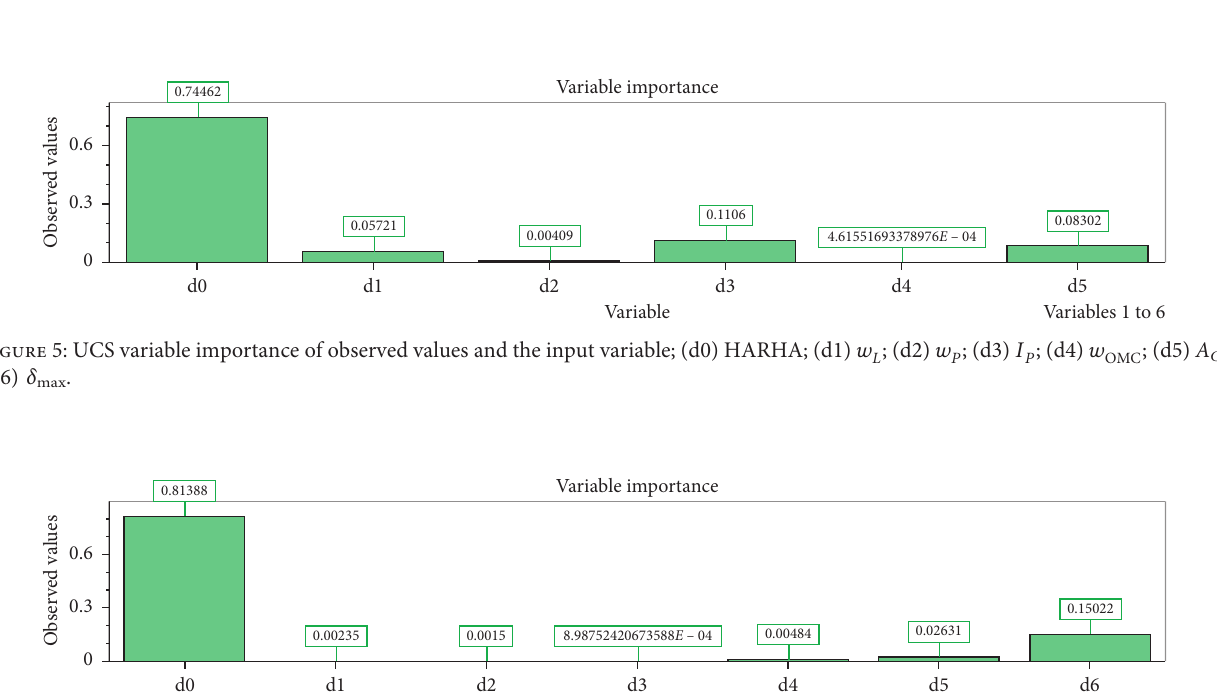
w I w ; (d5) L ; (d2) P ; (d3) P ; (d4) OMC